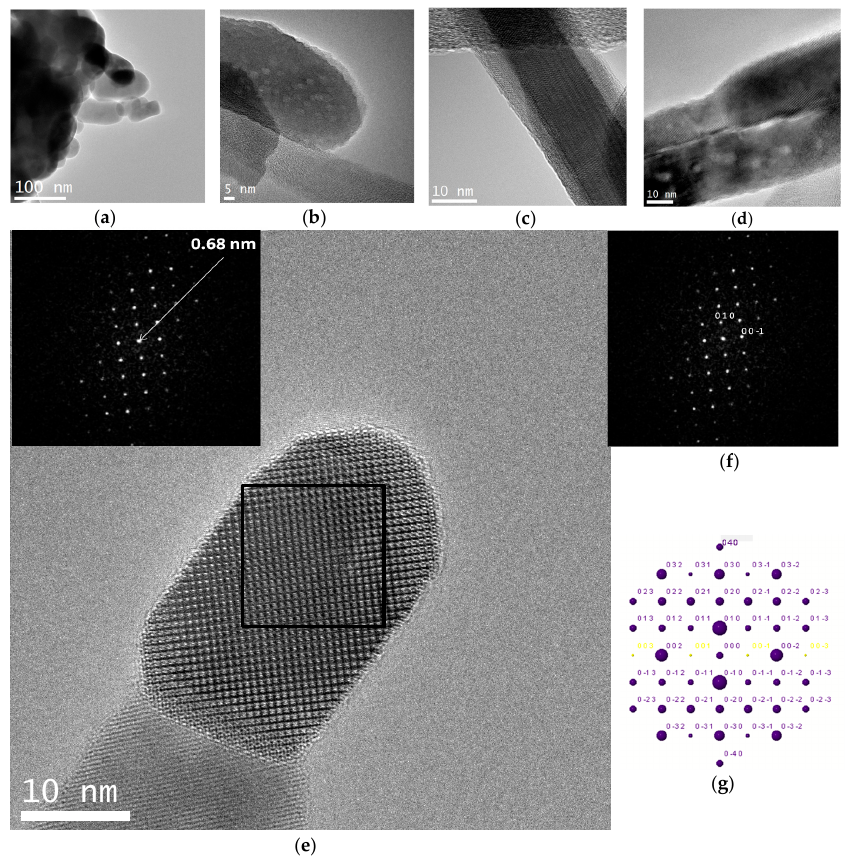
Figure 12. ( a – e ) HRTEM images of a C12GA-templated CePO 4 annealed at 900 °C under N 2 conditions, the inset of ( e ) showing the corresponding digital diffraction pattern (DDP) of the region of the nanofiber marked with an square, with indicated distance; ( f ) same DDP with some indexed ( hkl ) values; ( g ) corresponding simulated kinetic diffraction diagram.